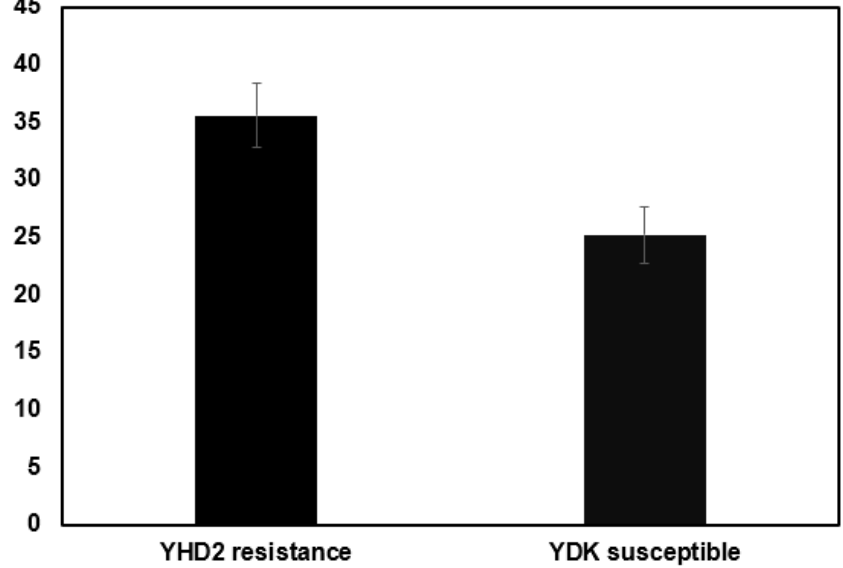
Figure 4. Fecal production over 24 h of Cry1Ac-susceptible Chloridea virescens neonates (YDK strain) versus Cry1Ac resistant C. virescens neonates (YHD2 strain) on artificial diet containing no Bt toxins (using the feeding disruption assay) (n = 56 and 64, respectively). Error bars are ±1 standard error of the mean.